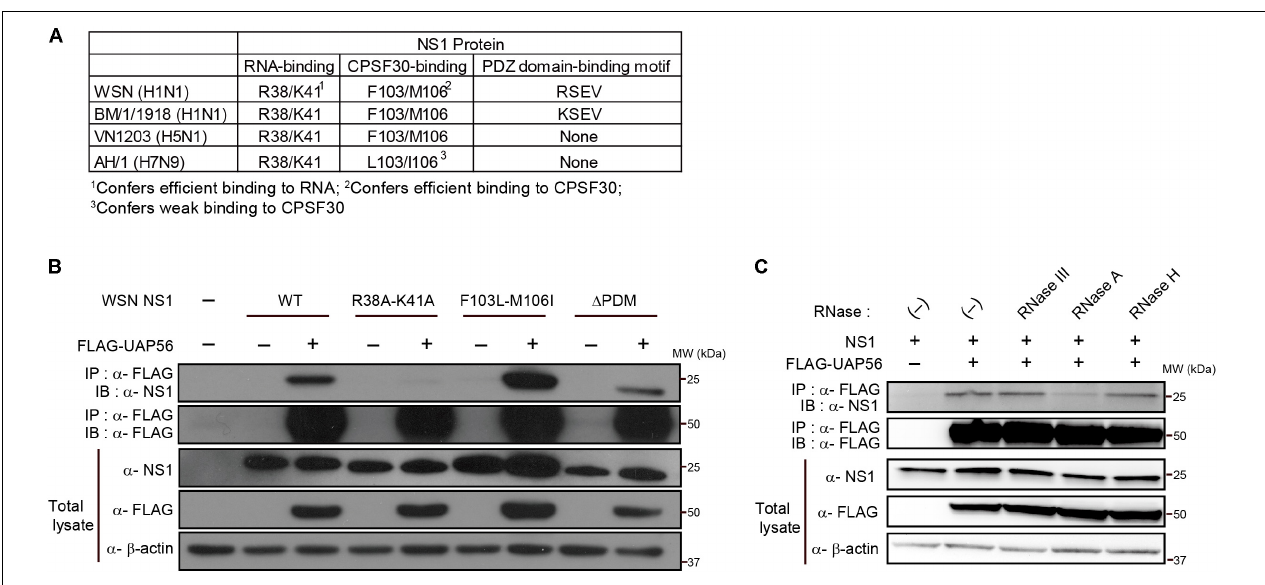
FIGURE 3 | Identification of NS1 residues critical for the UAP56–NS1 interaction. (A) Comparison of RNA-binding residues, CPSF30-interacting residues, and PDZ domain binding motifs among the NS1 proteins of WSN, BM/1/1918, VN1203, and AH1. (B) Interaction of UAP with mutant NS1 proteins. HEK293T cells were transfected with a protein expression vector for wild-type (WT) or mutant WSN-NS1 protein and FLAG-tagged UAP56 or a control vector. At 48 h post-transfection, the cells were lyzed and immunoprecipitated with anti-FLAG M2 antibody-conjugated magnetic beads. Co-precipitated proteins were analyzed by immunoblotting with anti-NS1 antibody. (cid:49) PDM: deletion of the “PDZ domain-binding motif.” (C) Effect of RNase treatment on the UAP56–NS1 interaction. HEK293T cells were transfected with plasmids for the expression of WSN-NS1 and FLAG-tagged UAP56. At 48 h post-transfection, the cells were lyzed and the collected cell lysate was mock-treated or treated with the indicated RNases at 37 ◦ C for 20 min. The lysates were incubated with anti-FLAG antibody-conjugated magnetic beads, and co-precipitated proteins were analyzed by